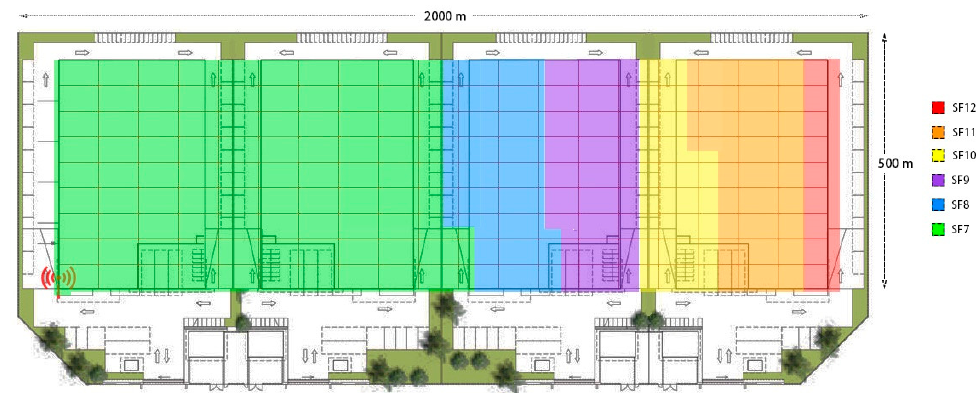
Figure 9. Results of SF for uplink traffic configured in every node at the end of the simulation, overlaid on the site map.